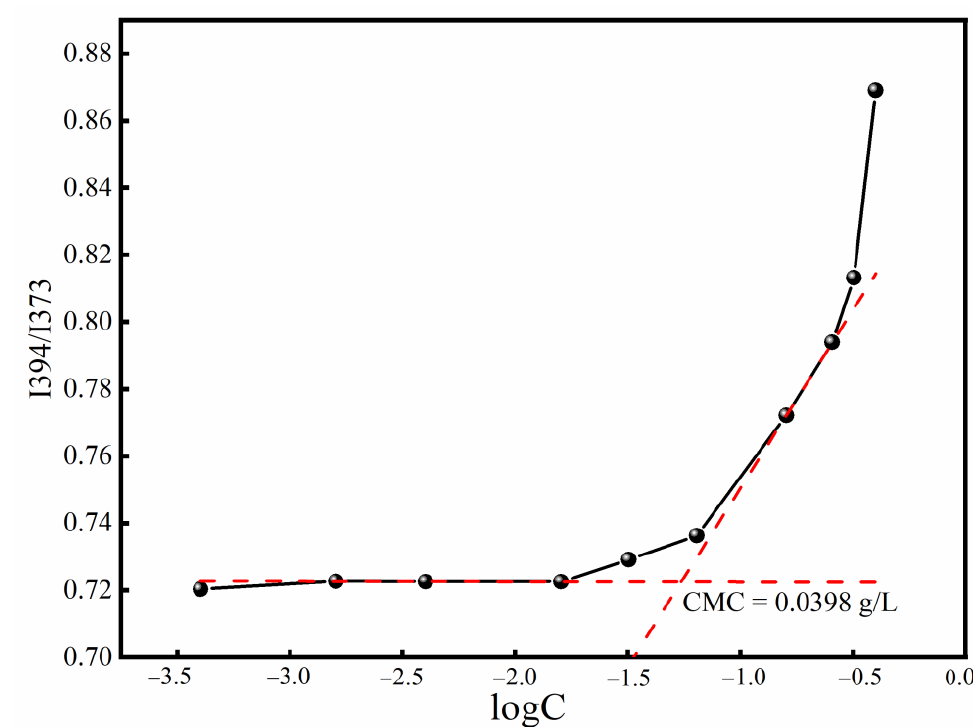
Figure 1. Variation of intensity ratio (I394/I373) versus logarithm of 6- β -CD-N-ODMA concentration.